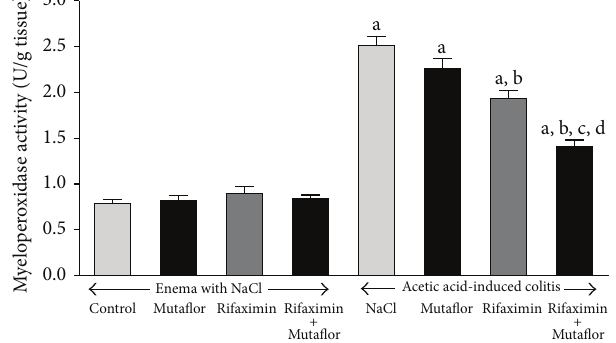
Figure 7: Influence of E. coli Nissle 1917 (Mutaflor) and rifaximin on myeloperoxidase activity in colonic mucosa in rats without or with acetic acid-induced colitis. Mean value ± SEM. 𝑁 = 8 animals in each experimental group and each time of observation. a 𝑃 < 0.05 compared to control saline-treated rats without induction of colitis; b 𝑃 < 0.05 compared to colitis + NaCl; c 𝑃 < 0.05 compared to colitis + Mutaflor; and d 𝑃 < 0.05 compared to colitis + rifaximin.